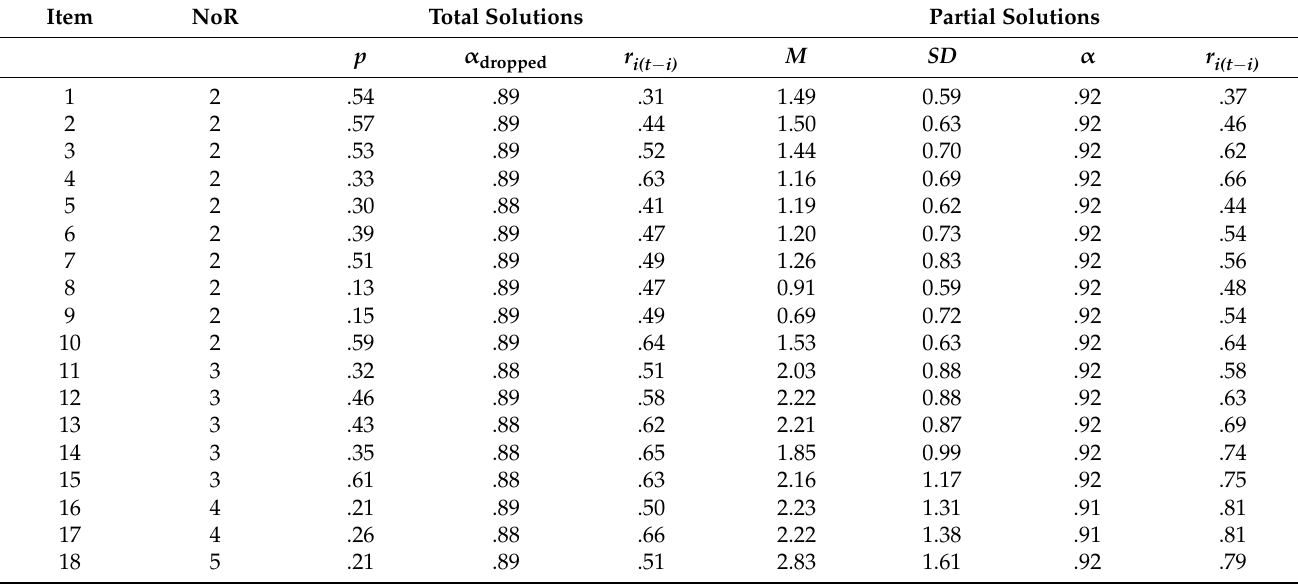
Table 1. Descriptive Statistics and Internal Consistencies.